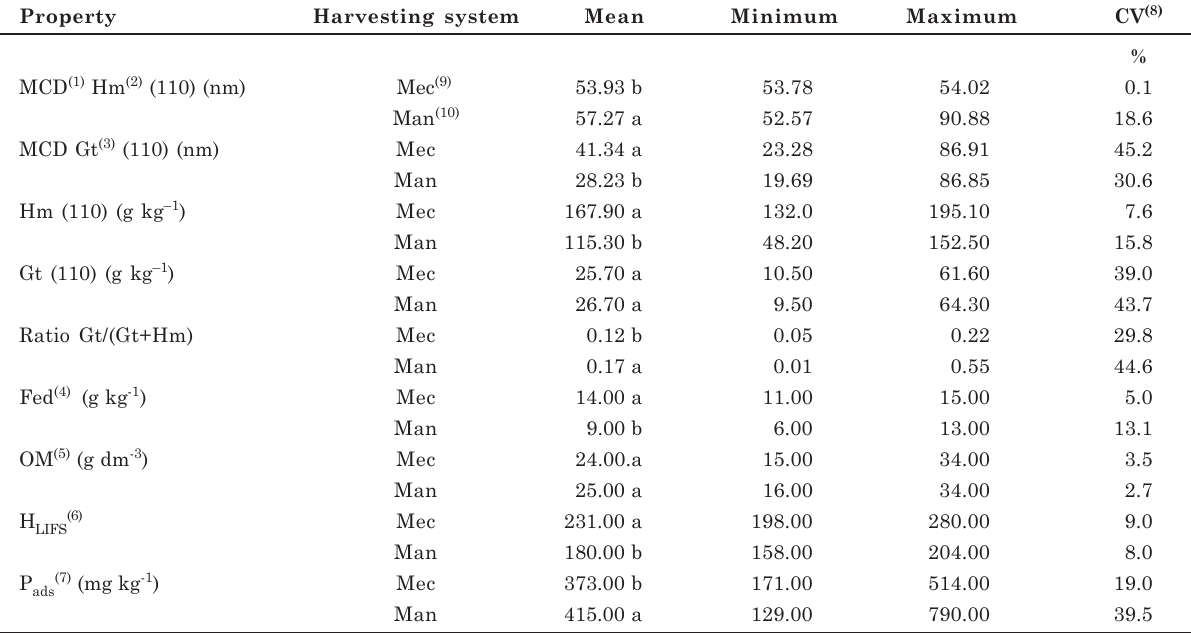
(1) Mean crystal diameter; (2) hematite; (3) goethite; (4) dithionite-extracted iron; (5) organic matter; (6) degree of humification;